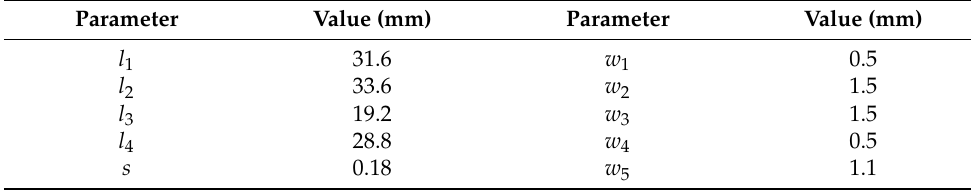
Table 1. Physical parameters of the proposed